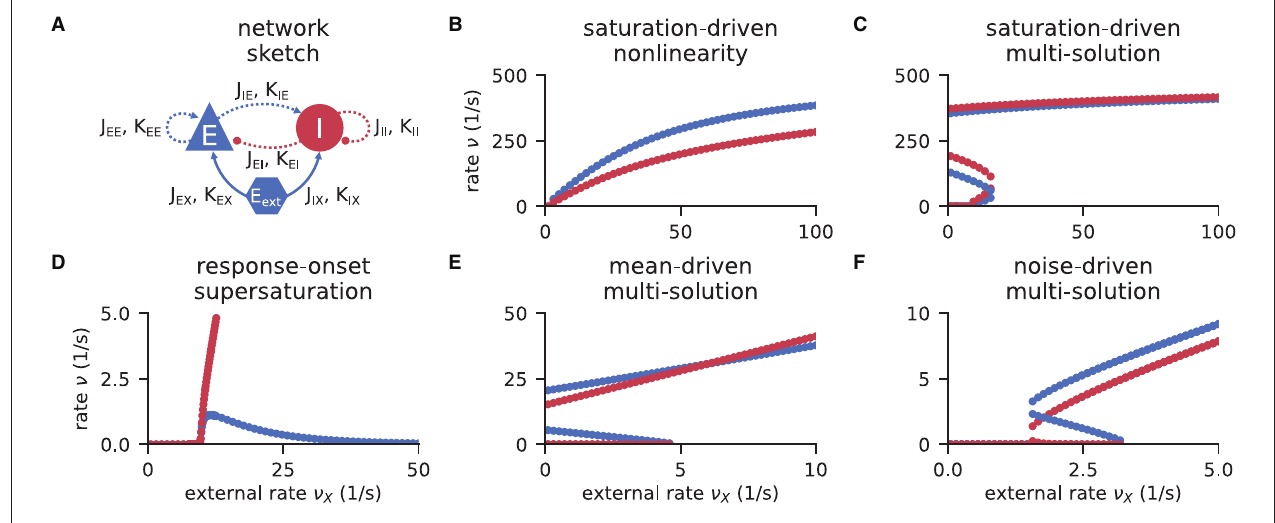
FIGURE 2 | Response nonlinearities in EI-networks. (A) Network diagram with nodes and edges according to the graphical notation proposed by Senk et al. (in press) . (B–F) Firing rate of excitatory (blue) and inhibitory (red) population for varying external input rate ν X . Specific choices for synaptic weights ( J , J ext ) and